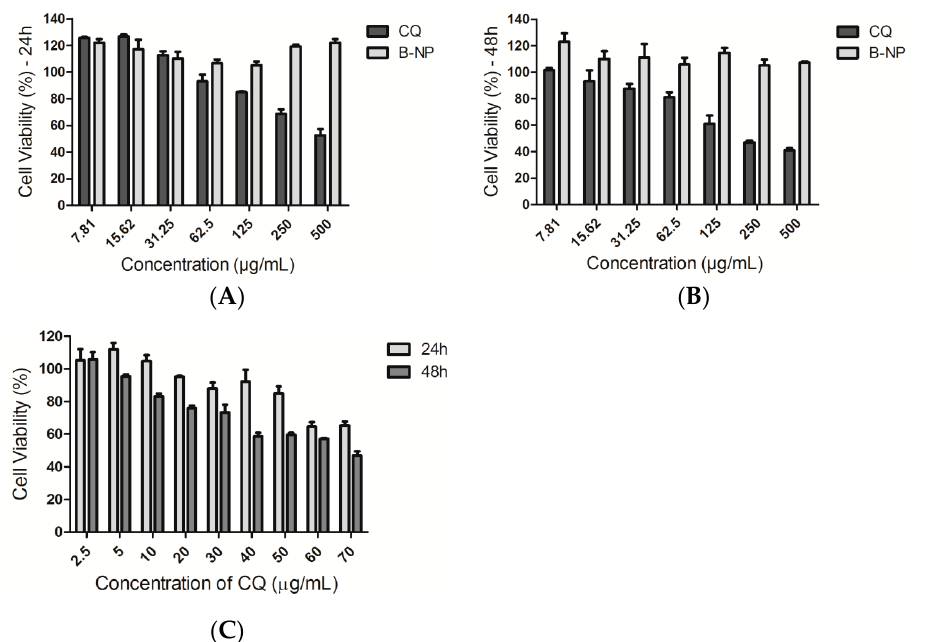
Figure 3. Cell viability in Vero E6 cells. Assay performed after the incubation of CQ and B-NP samples after ( A ) 24 h and ( B ) 48 h of incubation, respectively; and ( C ) assay performed after 24 h and 48 h of incubation for CQ-NP sample. Concentrations lower than 62.5 µg mL − 1 for CQ, and 30 µg mL − 1 for CQ-NP exhibited low cell cytotoxicity when compared to untreated controls. On the other hand, all tested concentrations for B-NP did not induce significant cytotoxicity.